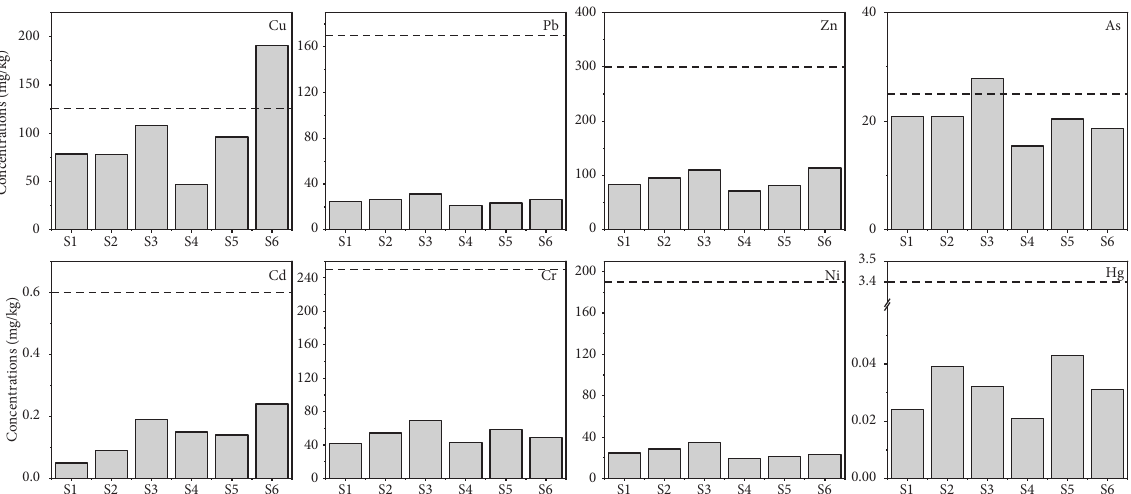
Figure 3: Heavy metal contents in the soils of the Tiegelongnan copper deposit area.